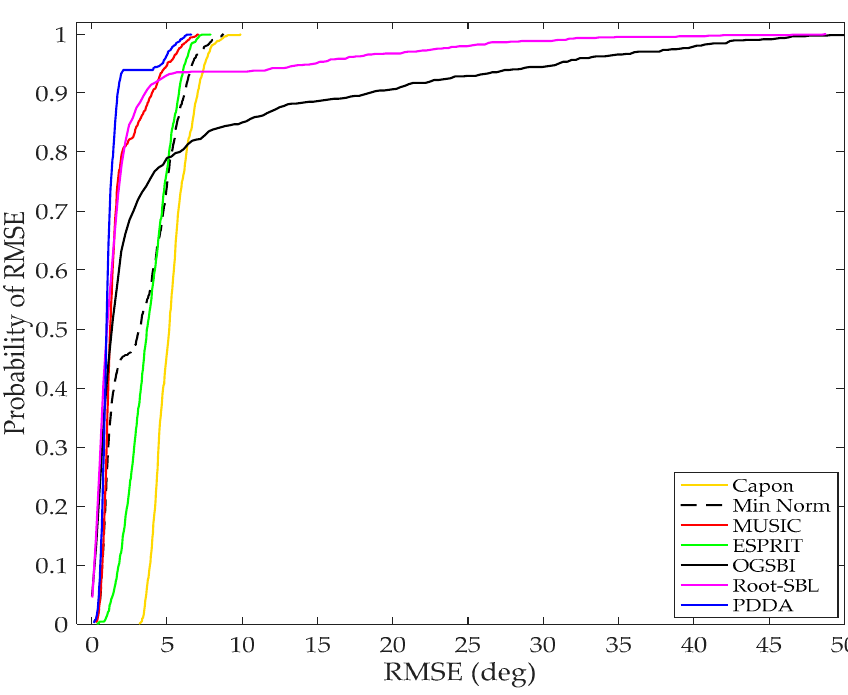
Figure 8. ARMSE vs. SNR, with M = 8, D = 2, N = 3, 1000 Monto Carlo simulations for each SNR.